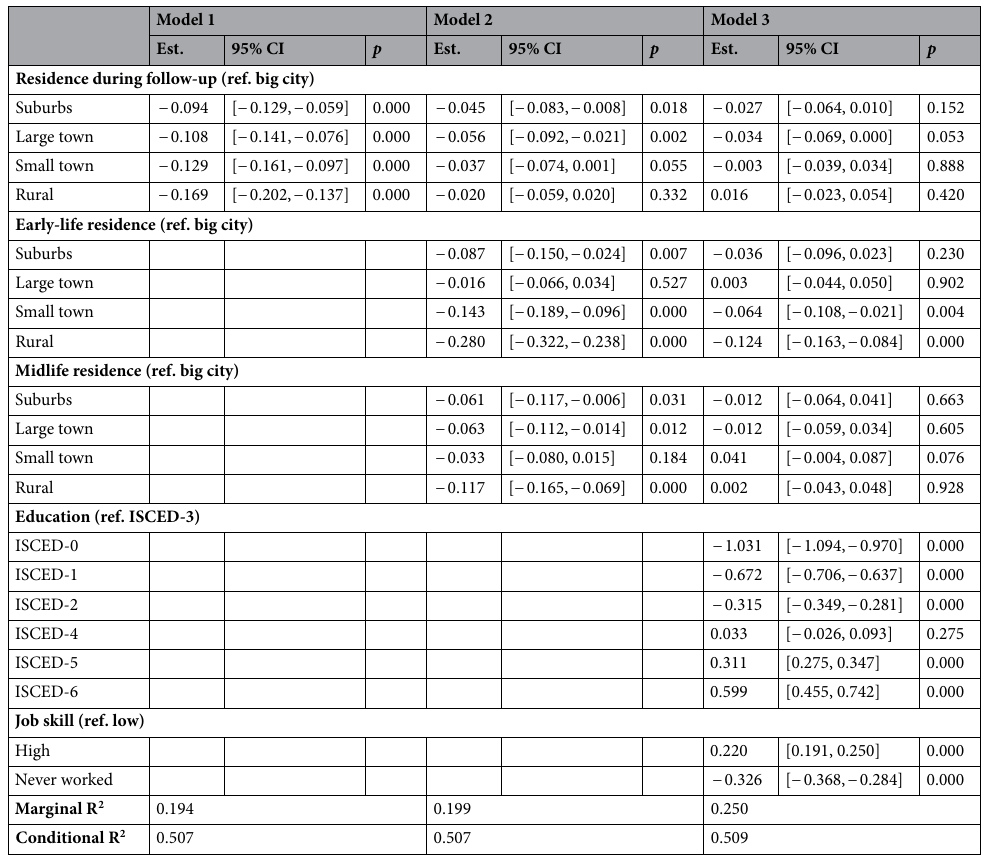
Table 1. Mixed-effects model estimates for immediate recall. N = 38,165; N observations = 145,593. Adjusted for country of residence, age, sex, self-reported health, depression, and drinking and smoking behaviour. Marginal R 2 is the variance explained by the fixed effects. Conditional R 2 is the variance explained by the entire model including the random effects. CI : Confidence interval calculated using likelihood profile